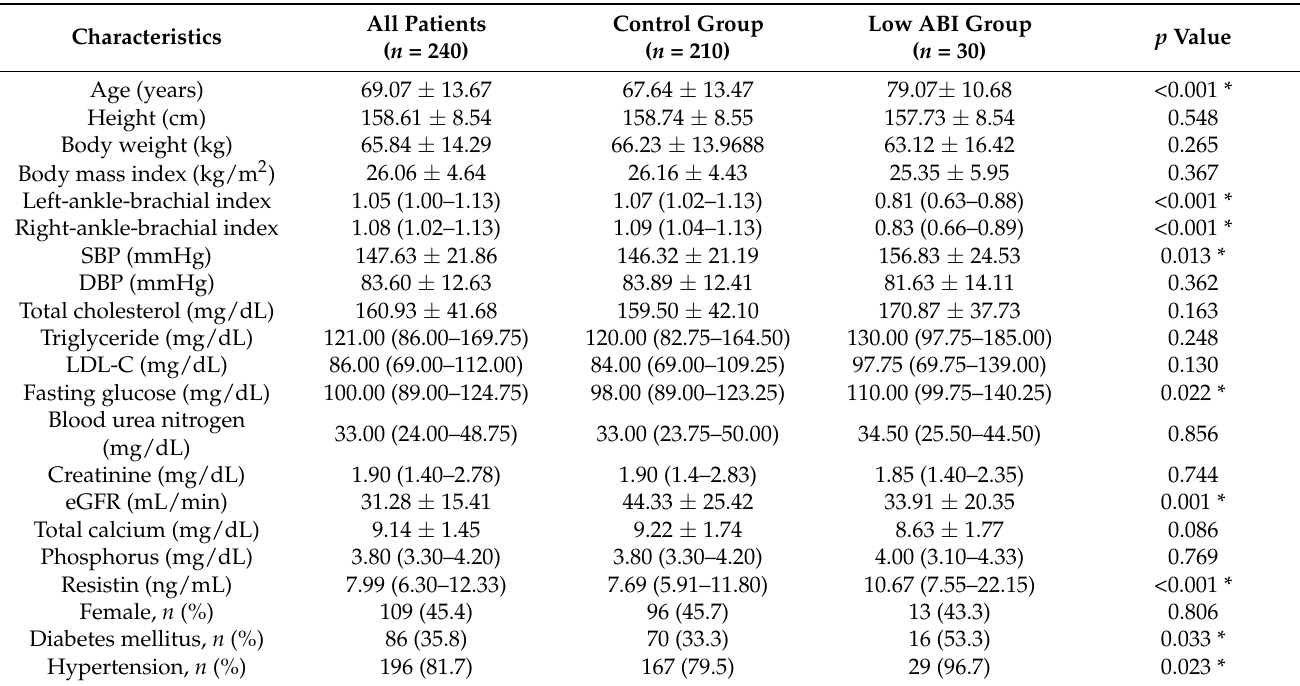
Table 1. Clinical variables of the 240 chronic kidney disease patients with normal or low ankle brachial index group.